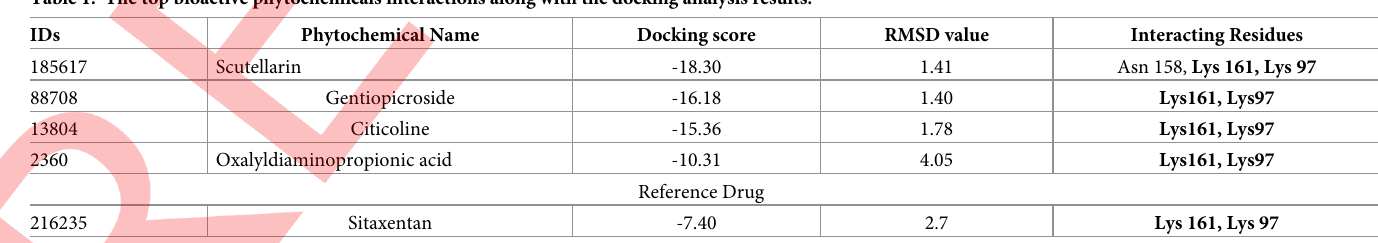
Table 1. The top bioactive phytochemicals interactions along with the docking analysis